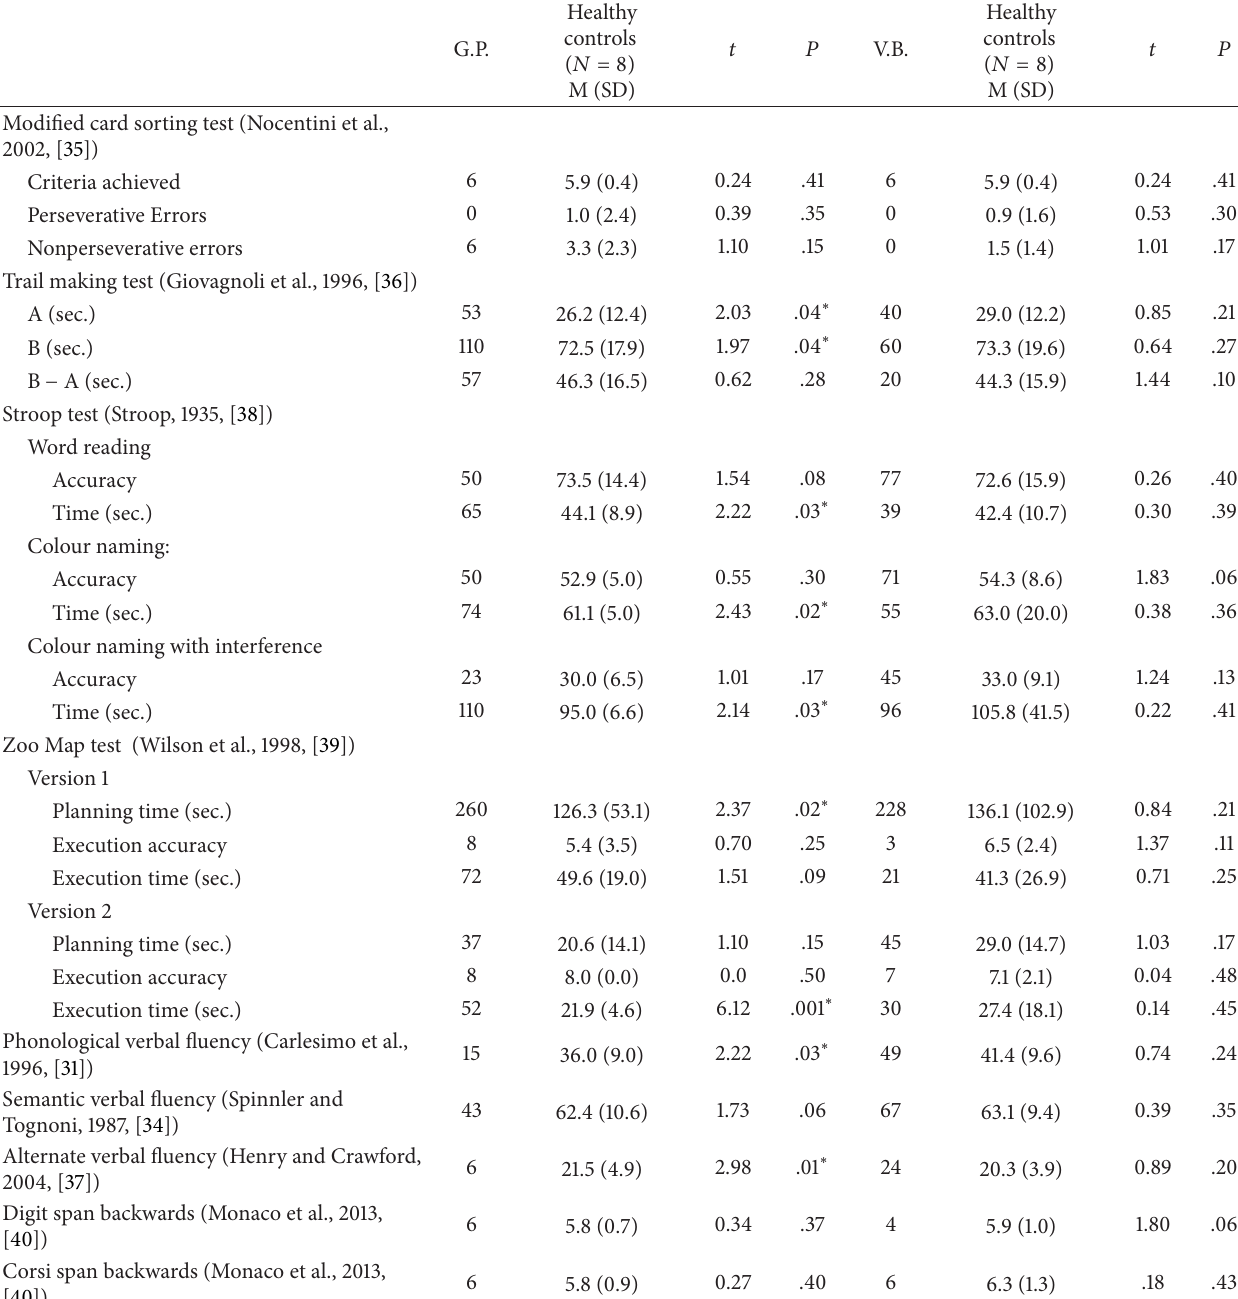
Table 2: Performance scores of G.P. and V.B. on the tests of executive battery. 𝑡 -tests for significant differences of individual scores from average scores of groups of normal controls are also